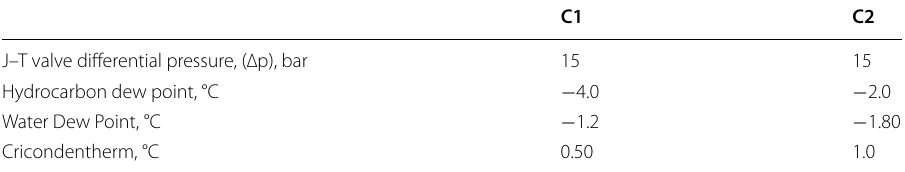
15 bars, the estimated values of hydrocarbon dew point, water dew point, and cricond- entherm using composition (C1) are those obtained using composition (C2) are these results meet pipelines specification of natural gas transmission.